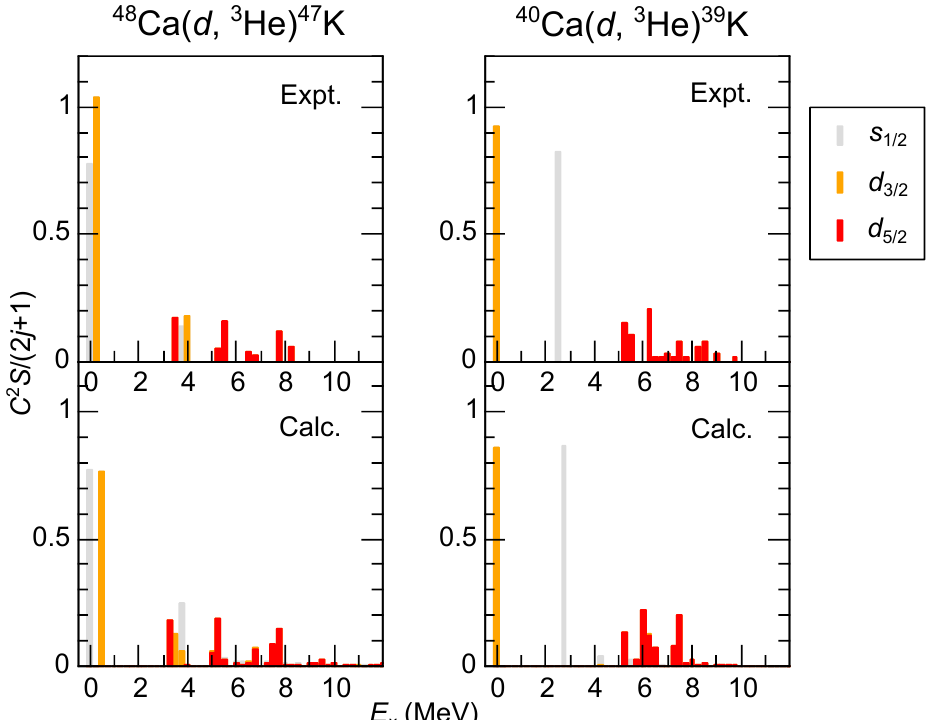
Figure 3. Distribution of the one-proton removal spectroscopic strengths (see Equation (8)) from 48 Ca ( left ) and 40 Ca ( right ) comparing experimentalal results (”Expt.”) with shell-model calculations (”Calc.”). The spectroscopic factors shown are divided by 2 j + 1 to normalize to unity for fully occupied orbitals. The bin widths are 0.25 MeV. Data are from Refs. [29] ( 48 Ca) and [30] ( 40 Ca). See text for